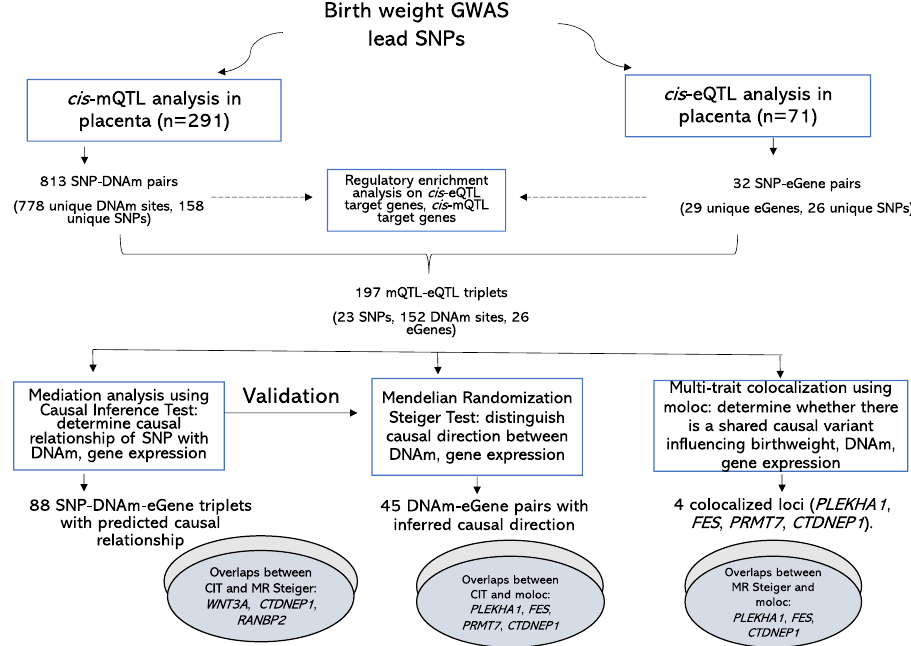
Fig. 1 Overview of study work fl ow. DNAm denotes DNA methylation, and eGene denotes an eQTL target gene in which gene expression in the placenta is regulated by a nearby genetic